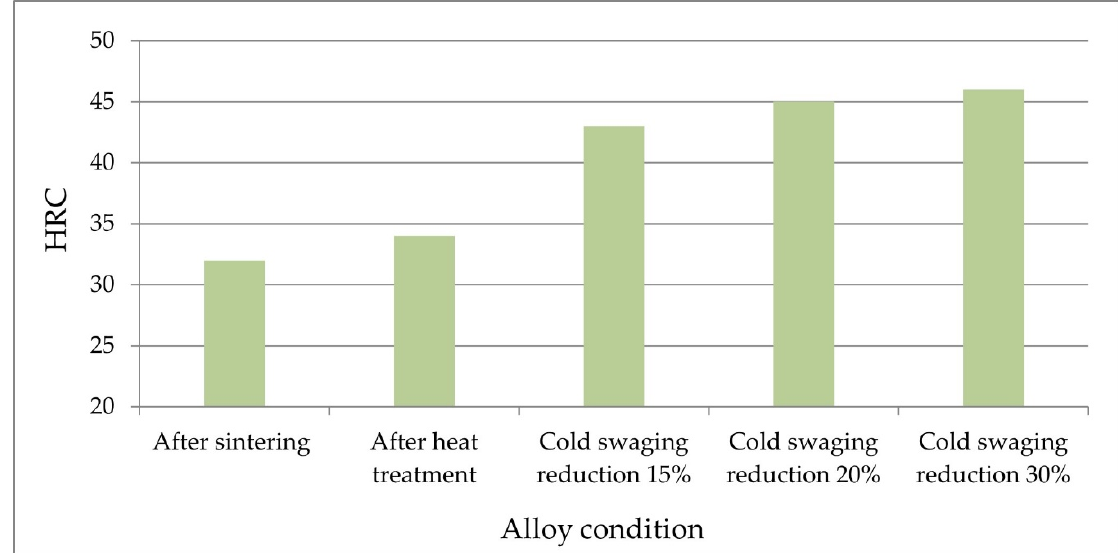
Figure 11. The results of the HRC hardness of the tungsten grains and the matrix measured along the bar axis.